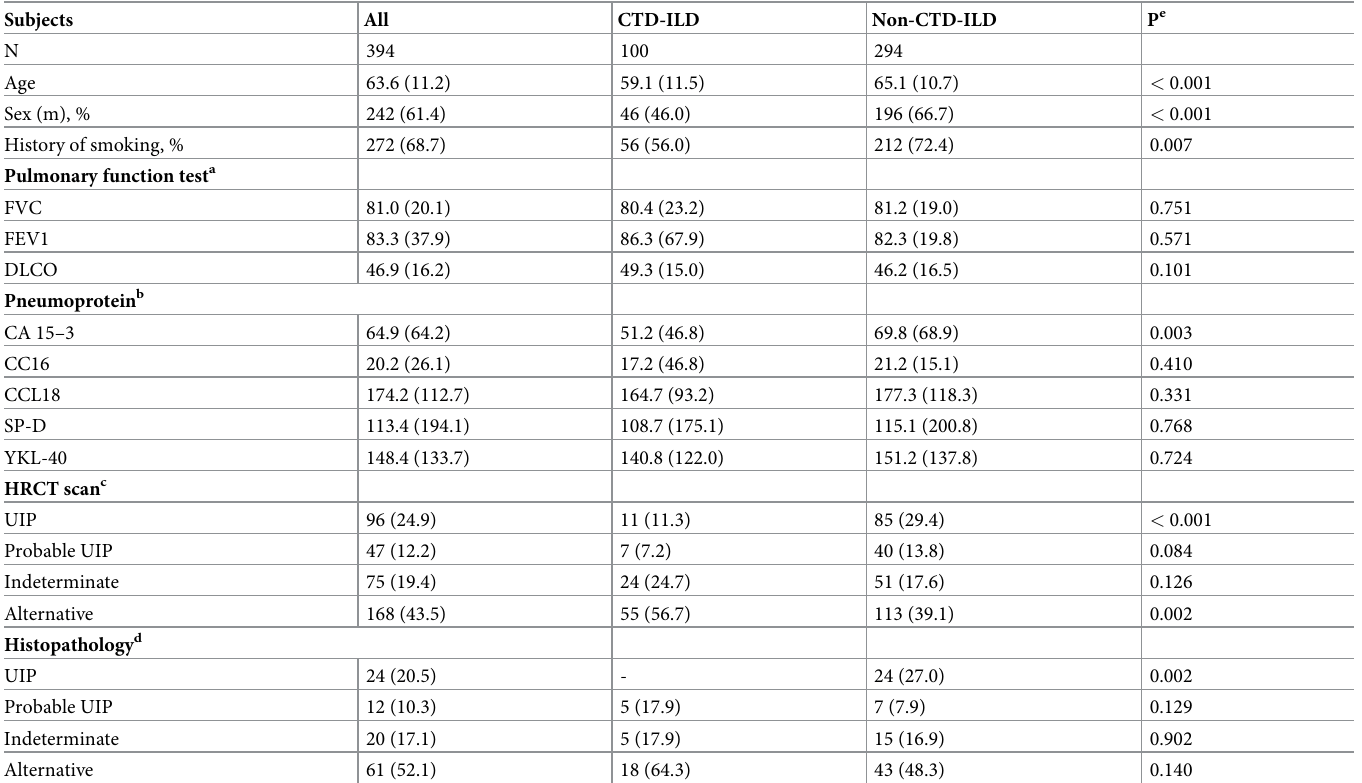
Table 1. Baseline characteristics of 394 patients with